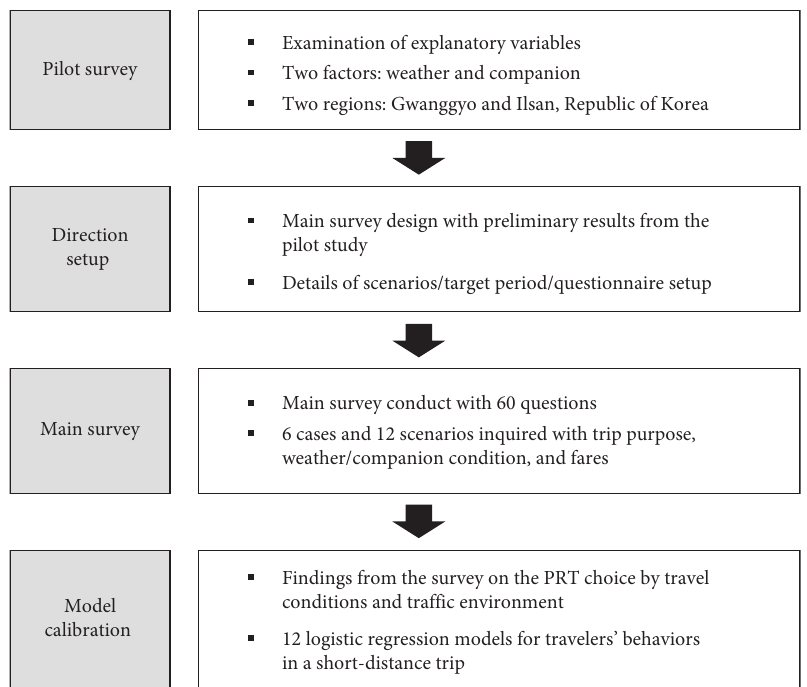
Figure 2: Overall procedure of the